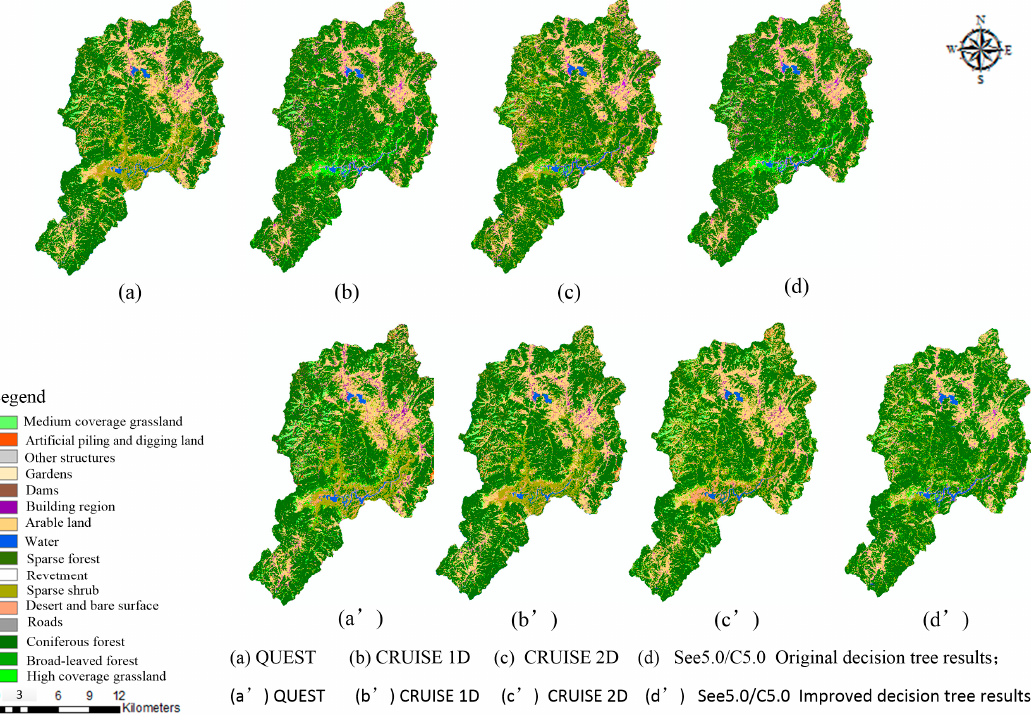
Figure 6. Land use/land cover classification results derived from the original and improved decision tree, respectively.